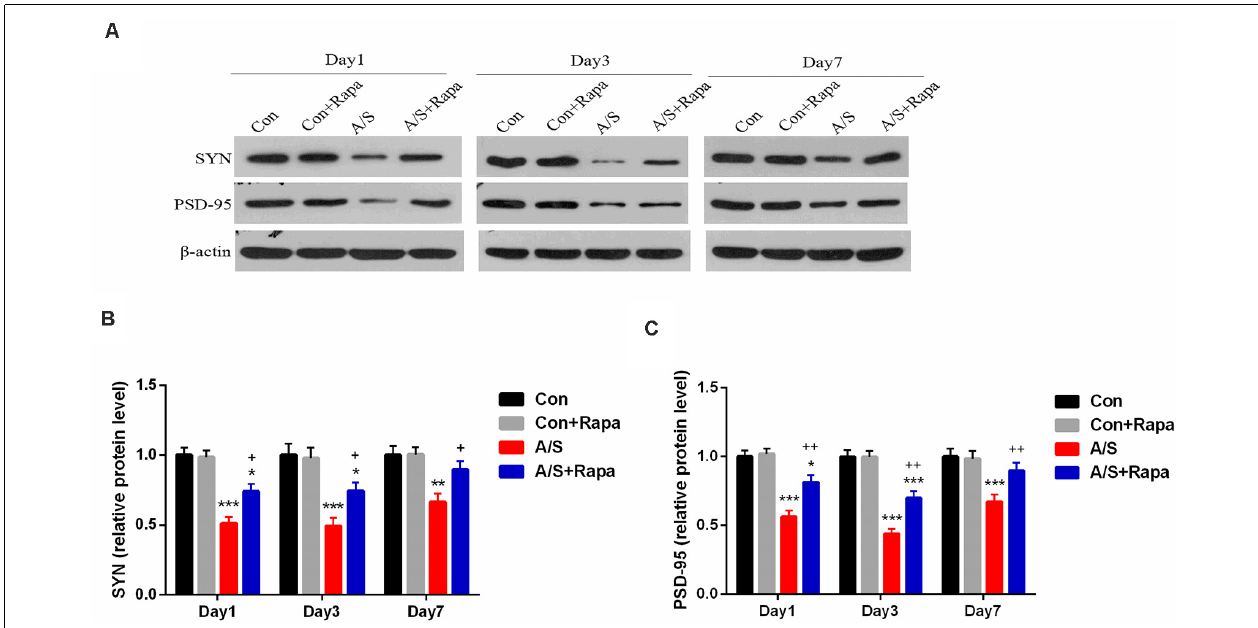
FIGURE 5 | Rapamycin treatment increased SYN and PSD-95 expression in the hippocampus. (A) Representative western blot illustrating the effects of rapamycin on the anesthesia/surgery-induced changes in hippocampal SYN and PSD-95 levels on days 1, 3 and 7 after anesthesia/surgery. (B,C) Rapamycin reversed anesthesia/surgery-induced decrease in SYN and PSD-95 levels in the hippocampus on days 1, 3 and 7 after anesthesia/surgery. Data are mean ± SEM ( n = 6 per group). *** p < 0.001, ** p < 0.01, * p < 0.05 vs. Con. ++ p < 0.01, + p < 0.05 vs. A/S. Con, control group; Con+Rapa, control group with rapamycin pretreatment; A/S, anesthesia/surgery group; A/S+Rapa, anesthesia/surgery group combined with rapamycin pretreatment.